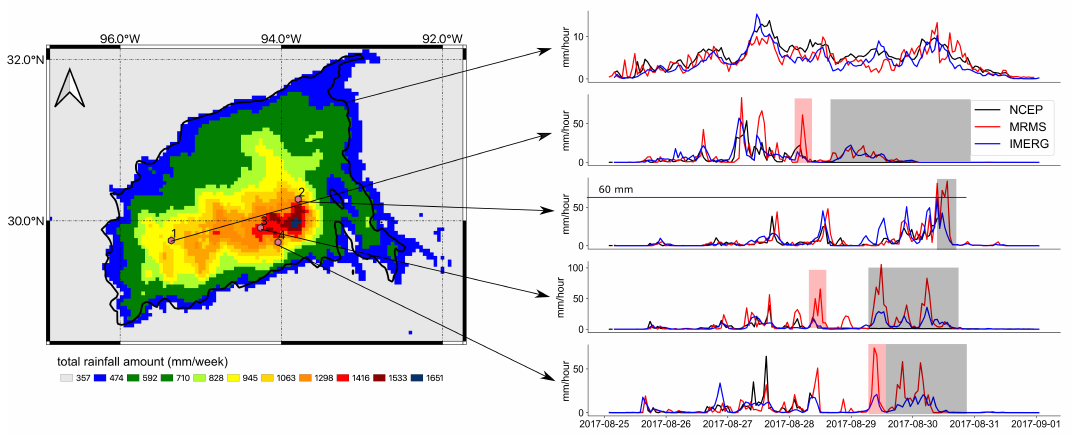
Figure 9. Core separated plot with selected pixel-wise time series. The black thick line in the left panel is the 400 mm accumulated rainfall contour line to separate the Harvey core regions. The windows in the right pane highlight special characteristics, with black corresponding to the NCEP observation, red for MRMS, and blue for Multi-satellitE Retrievals for GPM